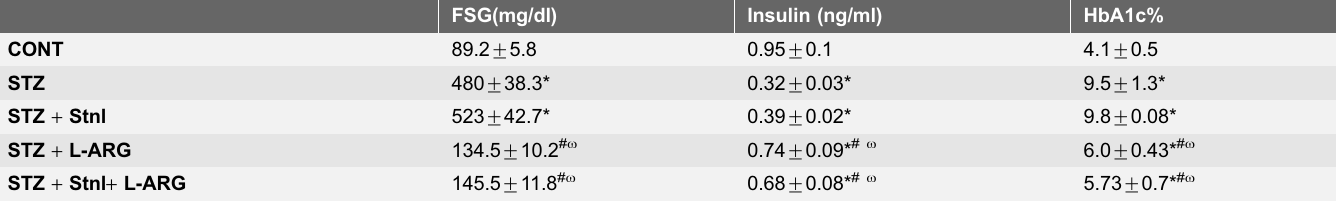
Table 2. Effect of STZalone, or in combination with Stnl, L-ARG or L-ARG + Stnl on Fasting serum glucose (FSG), insulin and